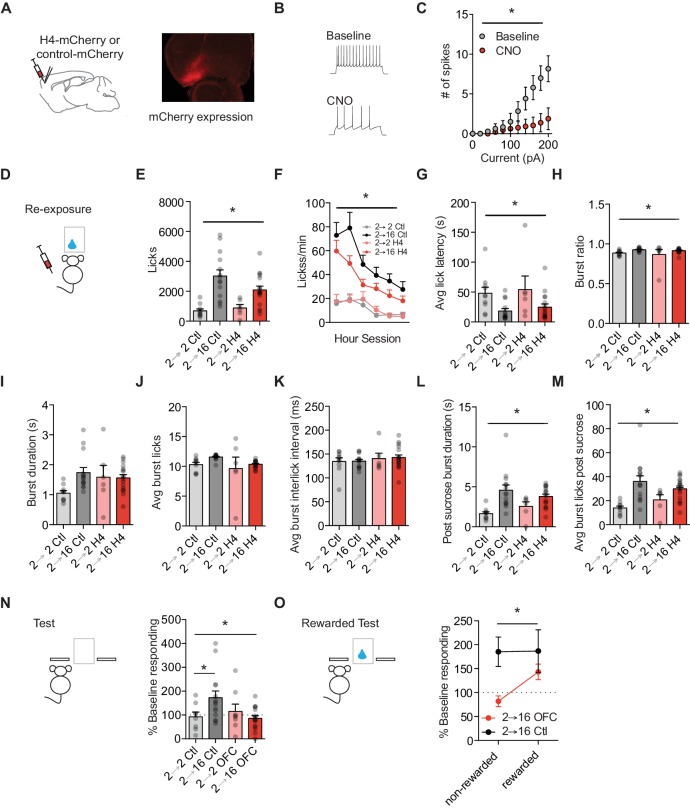
Orbitofrontal cortex attenuation prevents positive incentive learning.(A) Schematic of injection site (left) and representative mCherry expression in OFC (right). (B) Representative traces and (C) summary data from ex vivo physiological whole cell recordings in HMD4i expressing OFC projection neurons during baseline and following CNO bath application to H4 slice. (cells n = 8). (D) Training and testing schematic showing when OFC manipulations were given, with CNO given only during the re-exposure session. Group n’s: 2→ 2 Ctl: n = 9; 2→ 16 Ctl: n = 14; 2→ 2 H4: n = 7; 2 → 16 H4: n = 17. (E) Number of licks and (F) licking rate (10 min bins) during the re-exposure session. (G) The average latency to begin licking after a sucrose delivery (s). (H) The ratio of licks that occur in bursts, (I) average duration of bursts (s), (J) average number of licks within a burst, and (K) average interlick interval within bursts (ms). (L) Average burst duration after a sucrose delivery (s) and (M) average number of licks within a burst after a sucrose delivery. (N) Response rate during the 5 min non-rewarded test as a percent of acquisition response rate (last 2 days of training). (O) Percent of baseline responding from non-rewarded to the rewarded test Data points represent individual subjects and bar graphs and error bars represent the mean ± SEM. * indicates p<0.05.